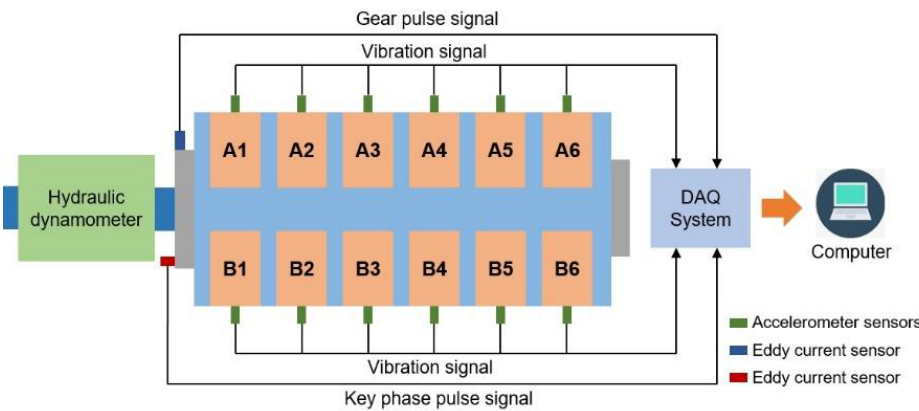
Figure 1. The interconnection of the main test rig components.